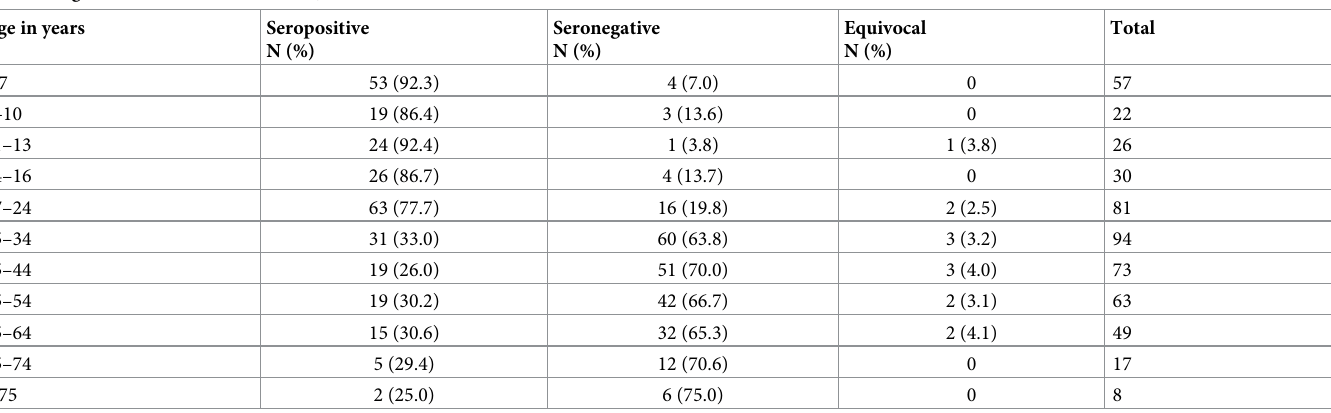
Table 3. Age stratified detection of anti-JEV